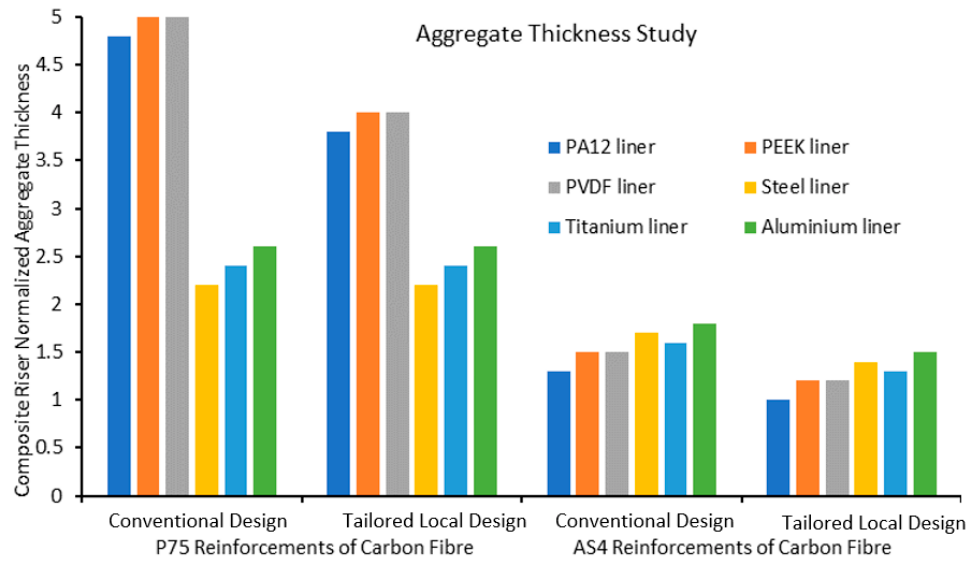
Figure 20. Comparative study at optimized angled plies for normalized aggregate thickness.